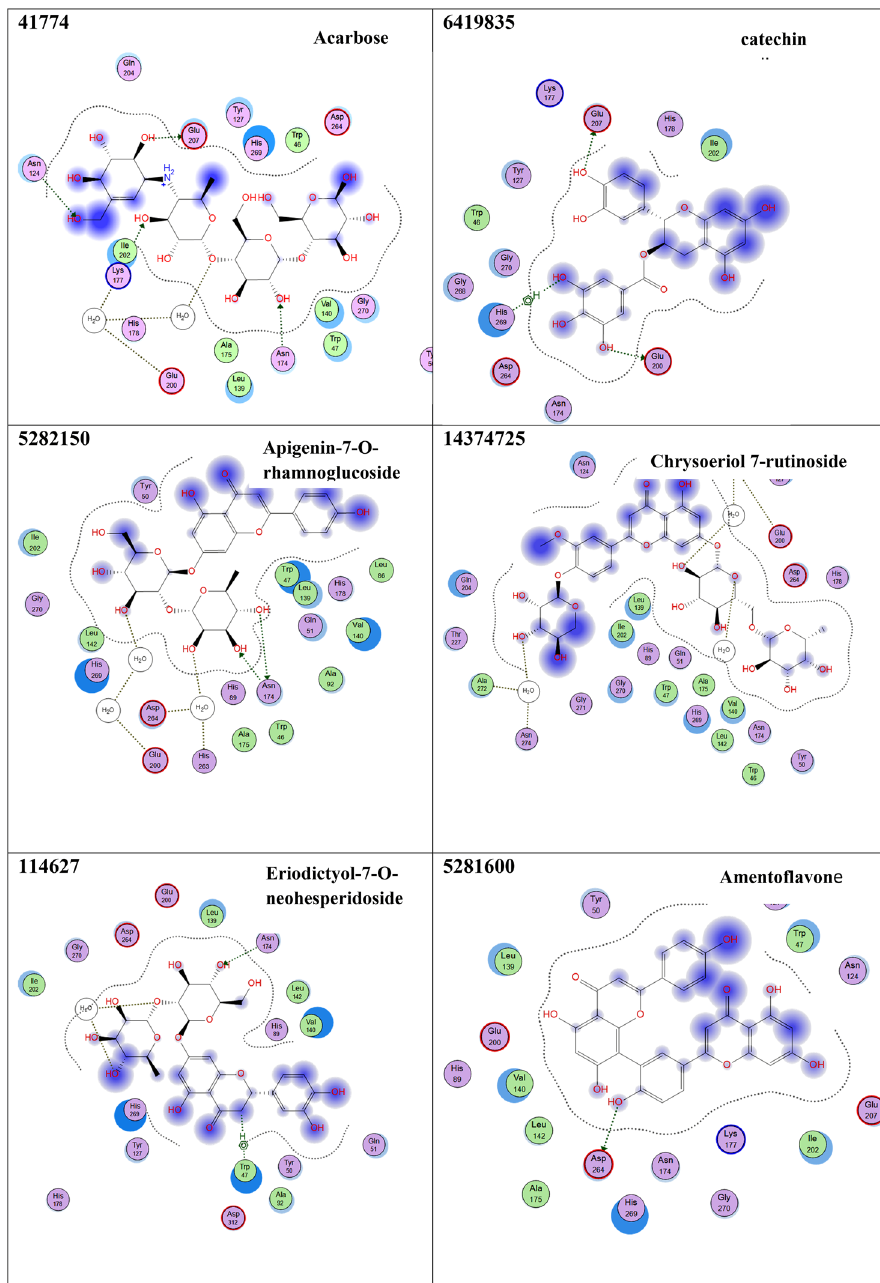
Figure 2. Interaction diagrams of the docked phytoligands i.e., 15 compounds with the active sites of α-amylase (PDB: 1Kxh). Green arrow represents side chain acceptor/donor; blue arrow represents backbone acceptor/ donor; blue shadow represents ligand exposure. The studied phytoligands are depicted in Table